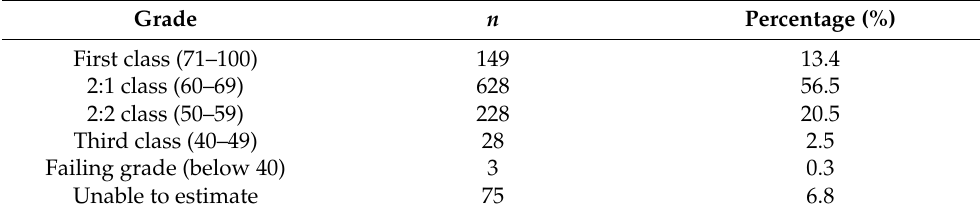
Table 2. Breakdown of students’ self-reported predicted grades ( N =